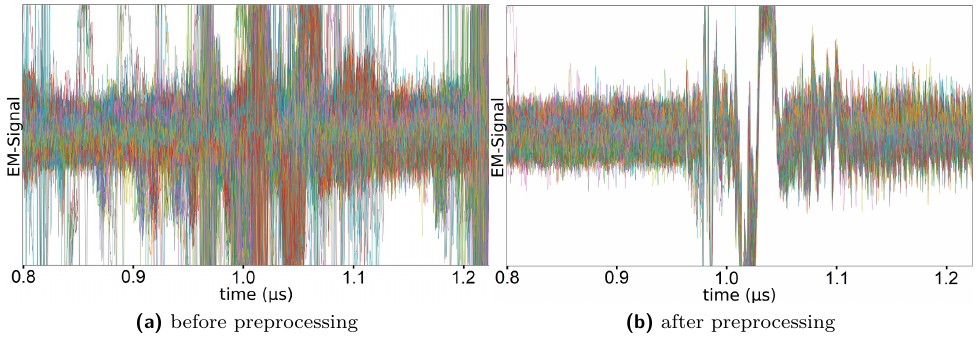
Figure 3: Superimposition of 500 EM traces before and after